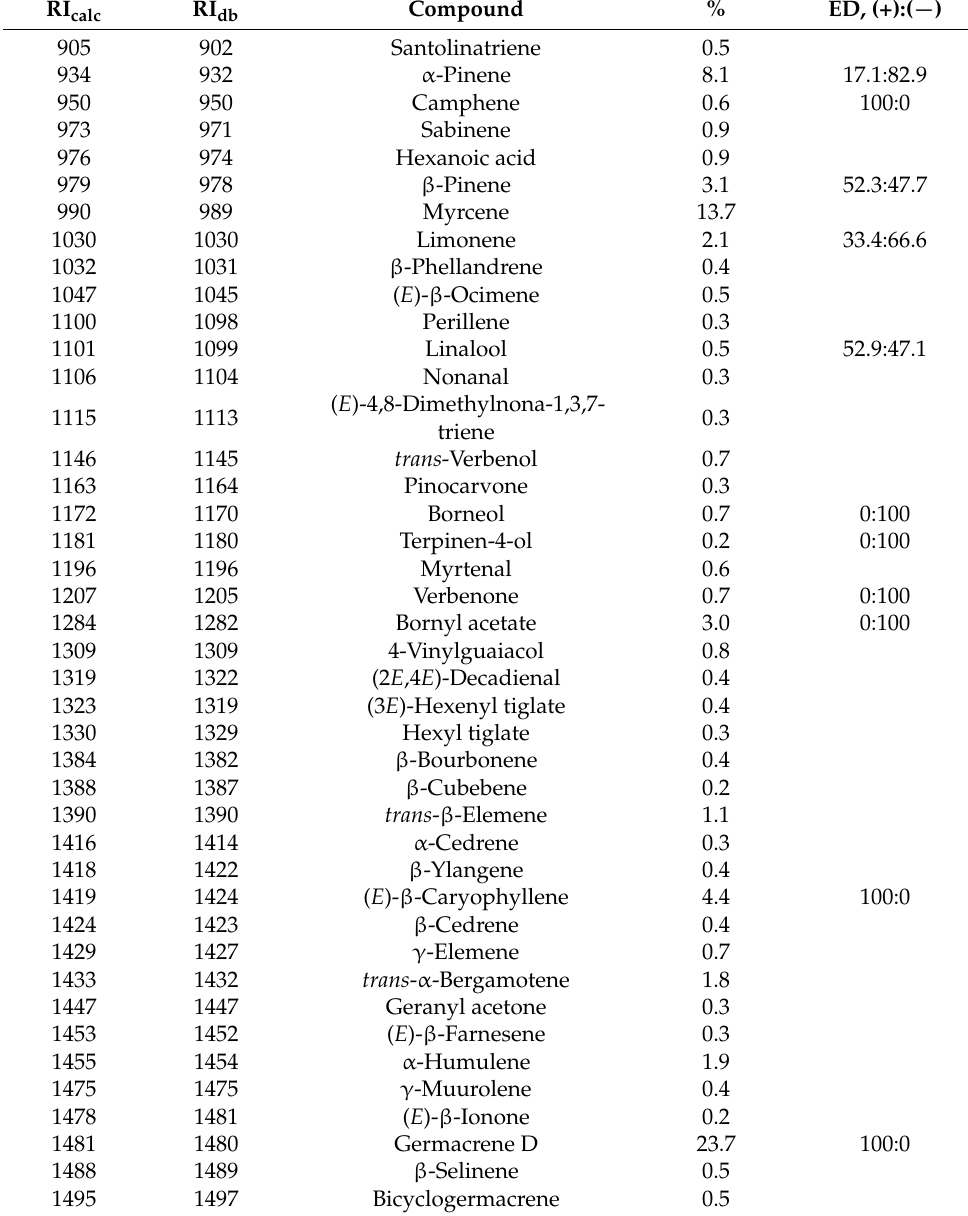
Table 5. Chemical composition of Liatris spicata aerial parts essential